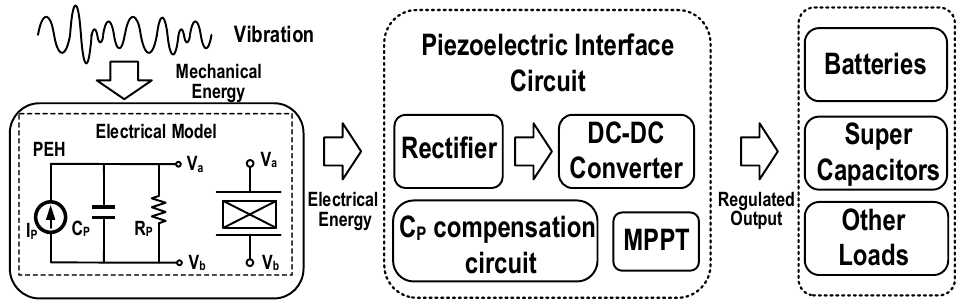
Figure 2. Block diagram of the piezoelectric energy harvesting system.